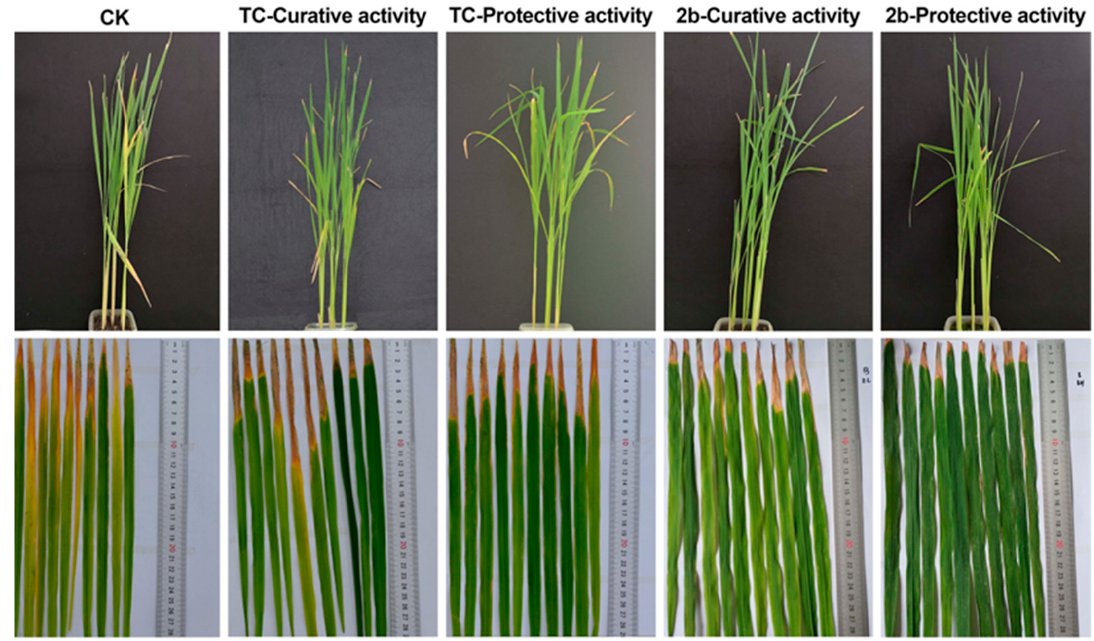
Figure 10. In vivo antibacterial activity of compound 2b and TC against rice bacterial leaf blight at 0 μ g mL − 1 (served as CK) and 200 μ g mL − 1 ; 2b : target compound 2b ; TC: thiodiazole copper; CK: blank control. Table 3. Compound 2b and TC at 200 μ g mL − 1 in vivo demonstrated both curative and protective activities against rice bacterial leaf blight under greenhouse conditions.